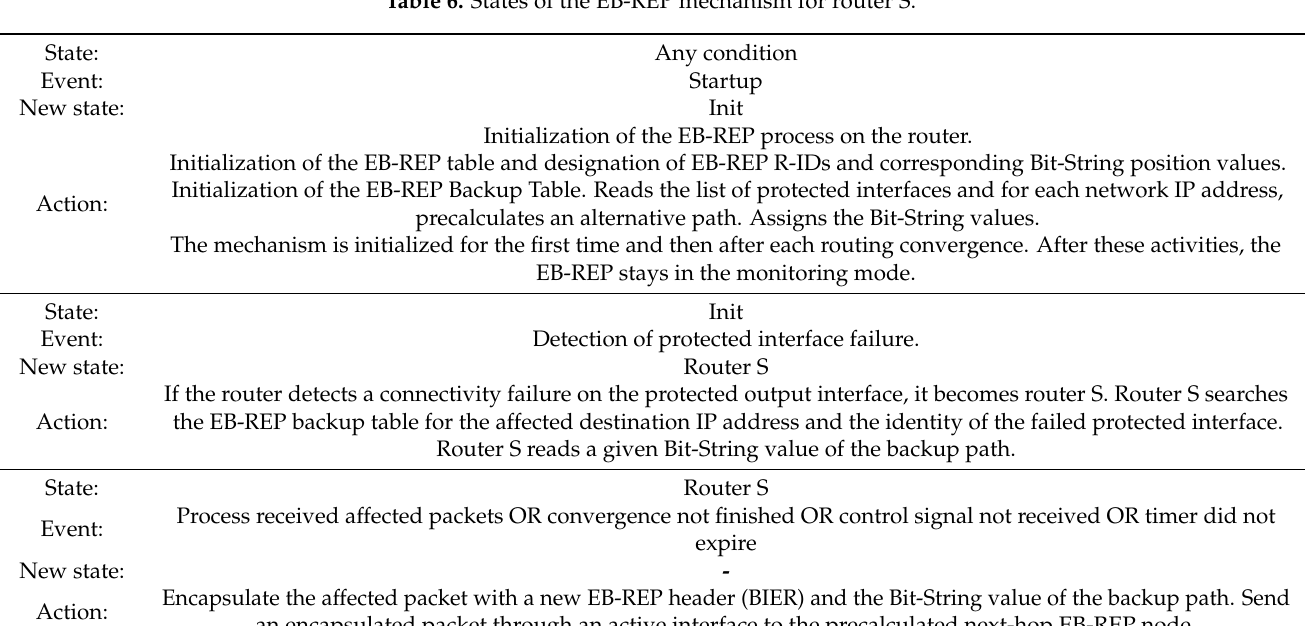
Table 6. States of the EB-REP mechanism for router